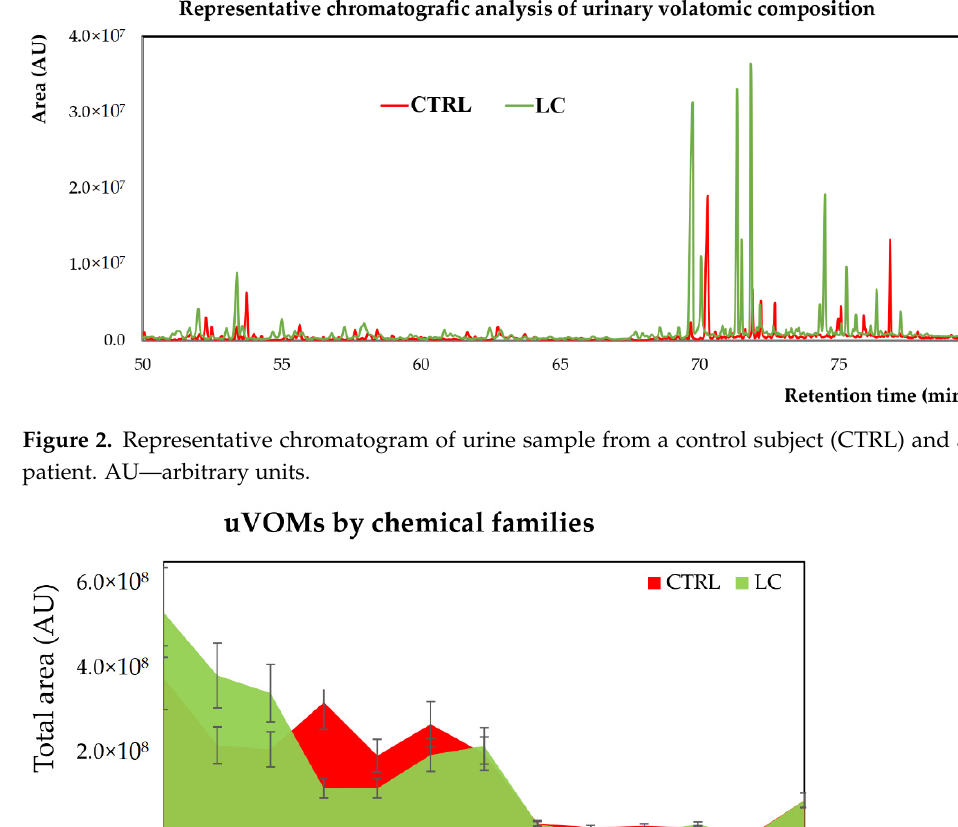
Figure 3. Distribution of the uVOMs identified in control (CTRL) and lung cancer (LC) individuals